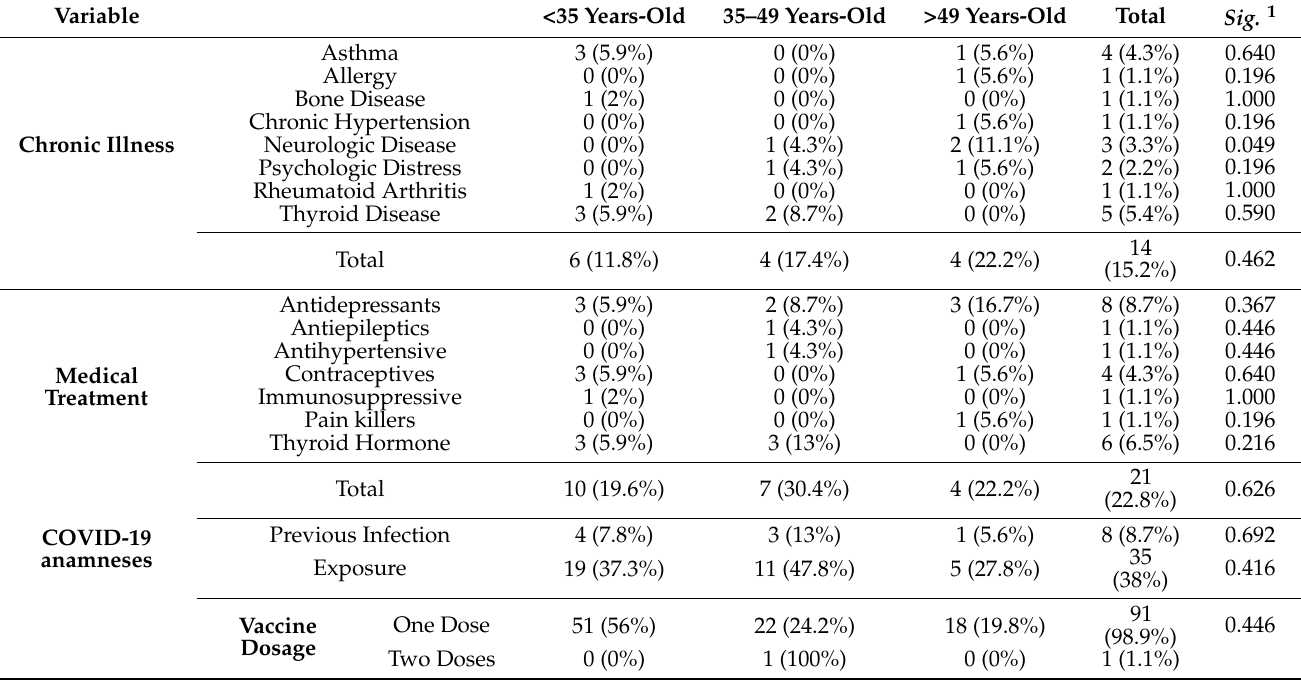
Table 2. Medical anamneses of European healthcare workers receiving the AstraZeneca COVID-19 vaccine, February–March